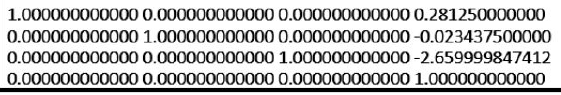
Figure 6. MBBC 4x4 matrix (Ahmad Fuad et al., 2018)